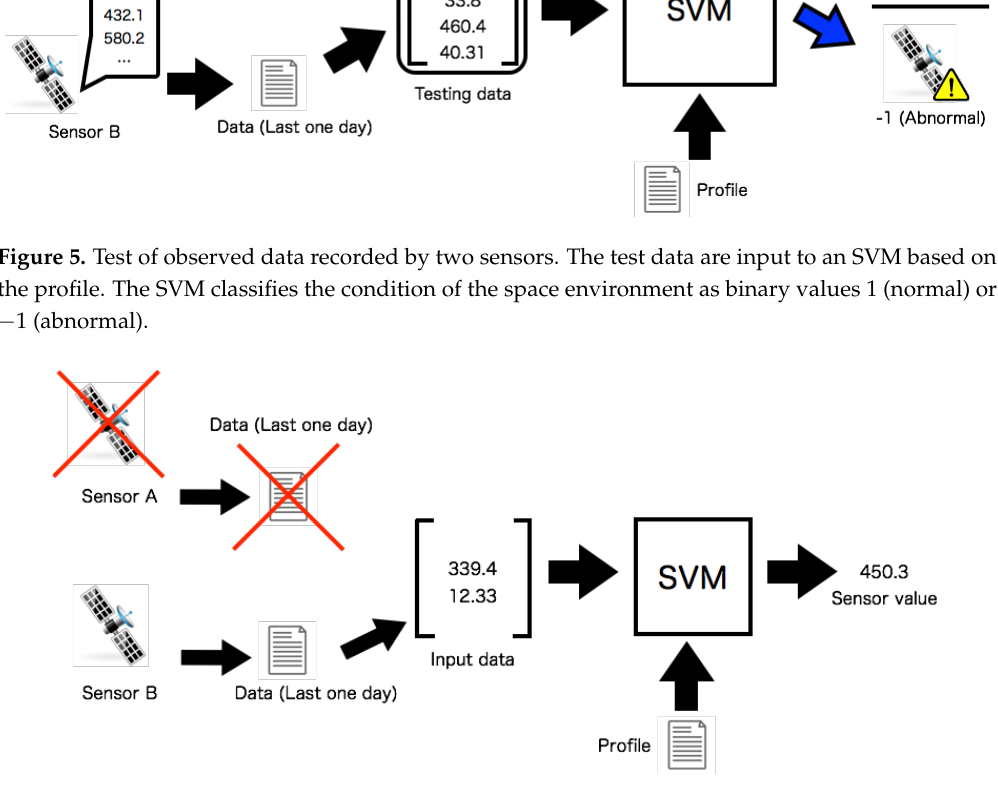
Figure 6. Interpolation process of missing data. The interpolation of the missing data is calculated by the data last one day of the opposite side. The interpolated value is calculated by the SVM with the input data and the predefined